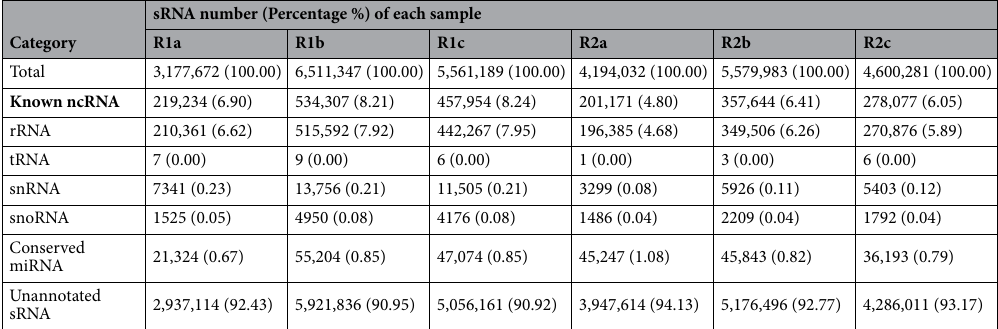
Table 1. Category distribution of unique sRNAs mapped to the A. bidentata transcriptome.